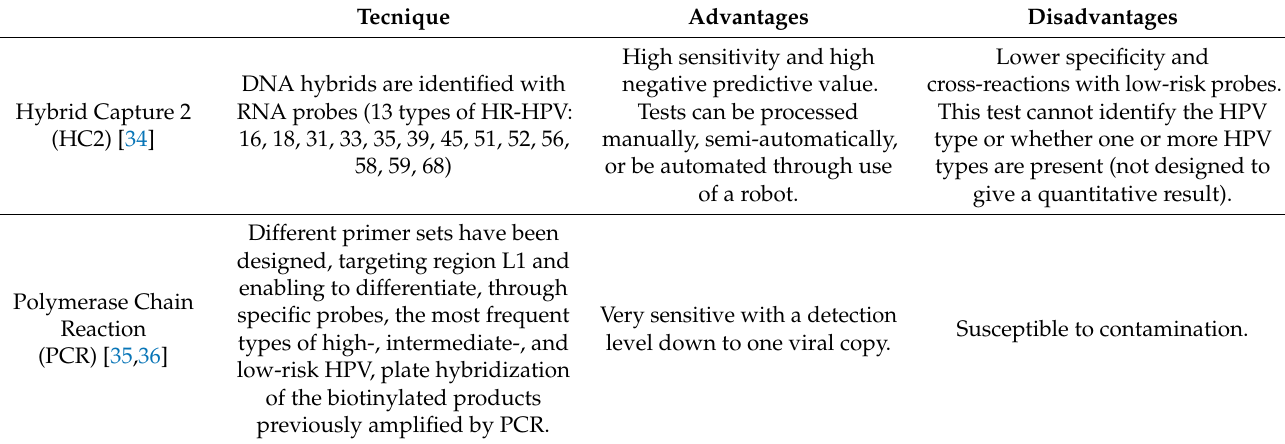
Table 3. Comparison of different HPV detection techniques.